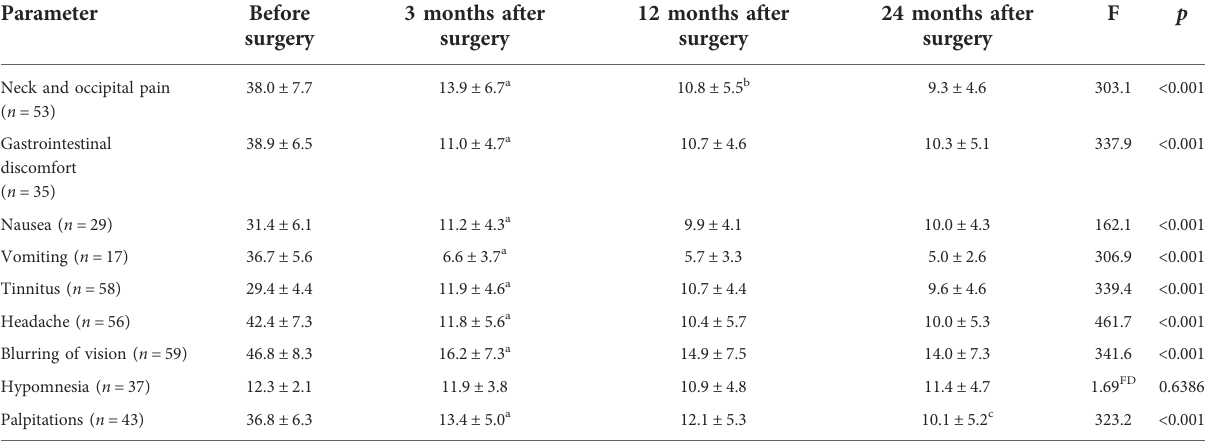
TABLE 8 Severity of symptoms accompanied with vertigo before and after surgery